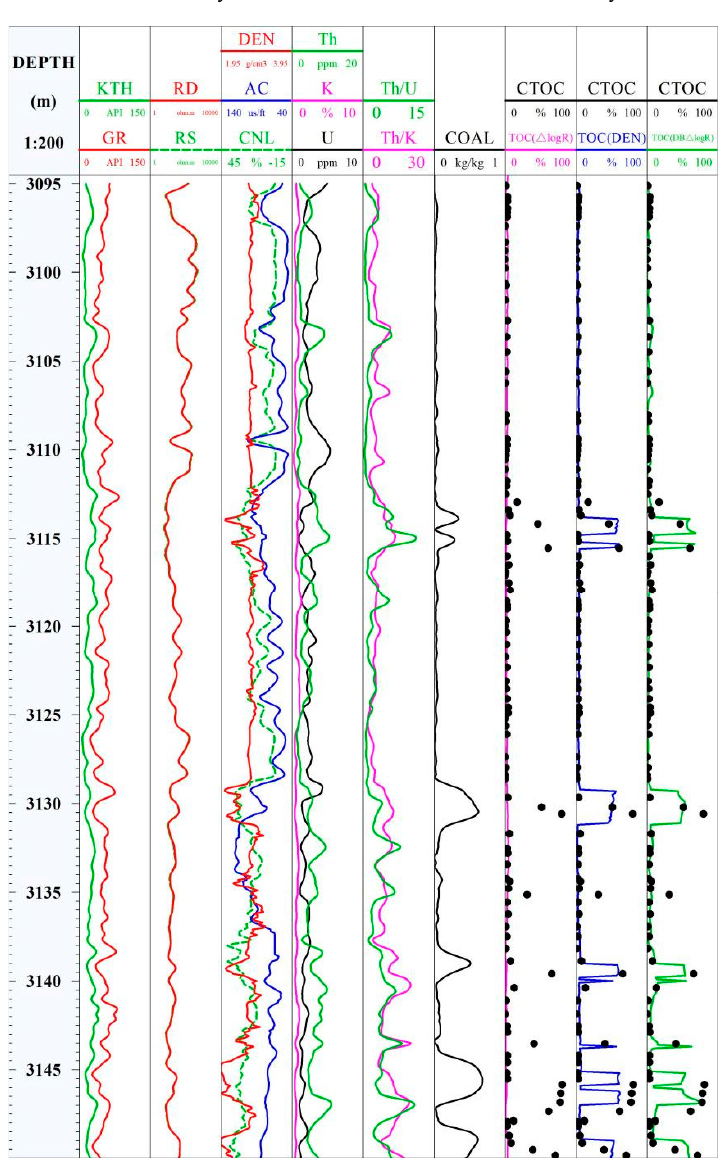
Figure 9. TOC calculation results of well C1.